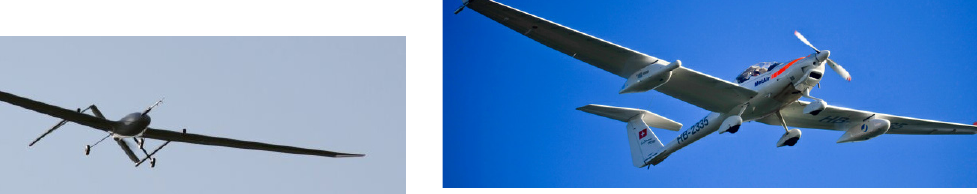
Figure 2: The SERA METAIR-DIMO (Motorglider Dia- mond Aircraft HK36-TTC-ECO, also called “ECO- Dimona”) with 16.5 m wing-span and up to 100 kg sci- entific payload, carried mainly in the under wing-pods of this special version (the two ARA-DIMOs are simi-